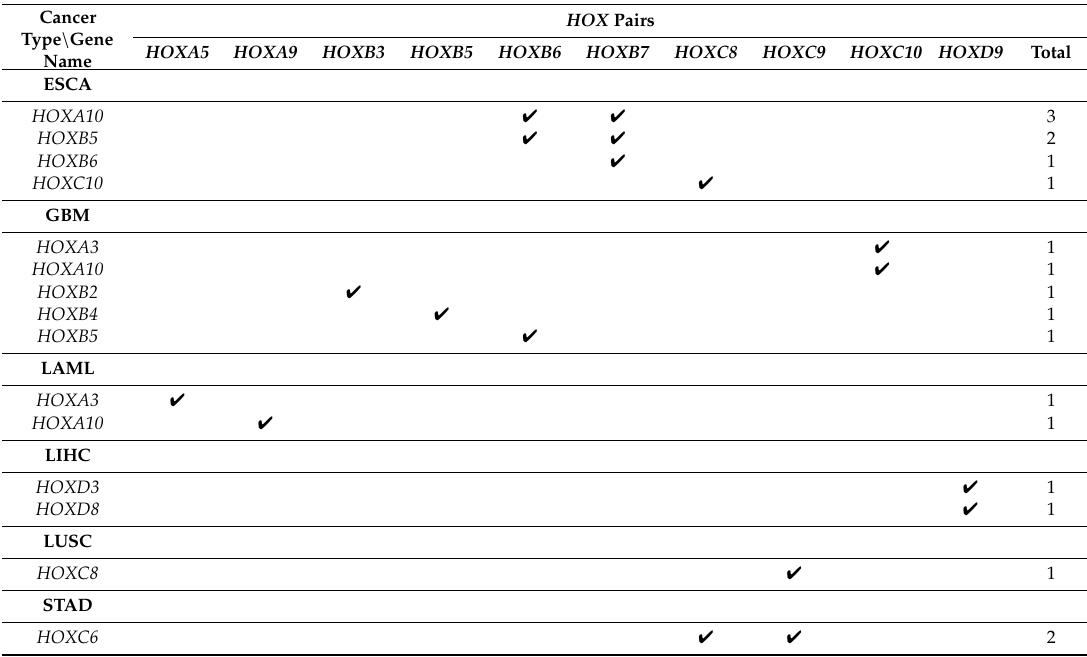
Table 4. HOX gene pairs with significant expression correlation categorized by cancer type 1